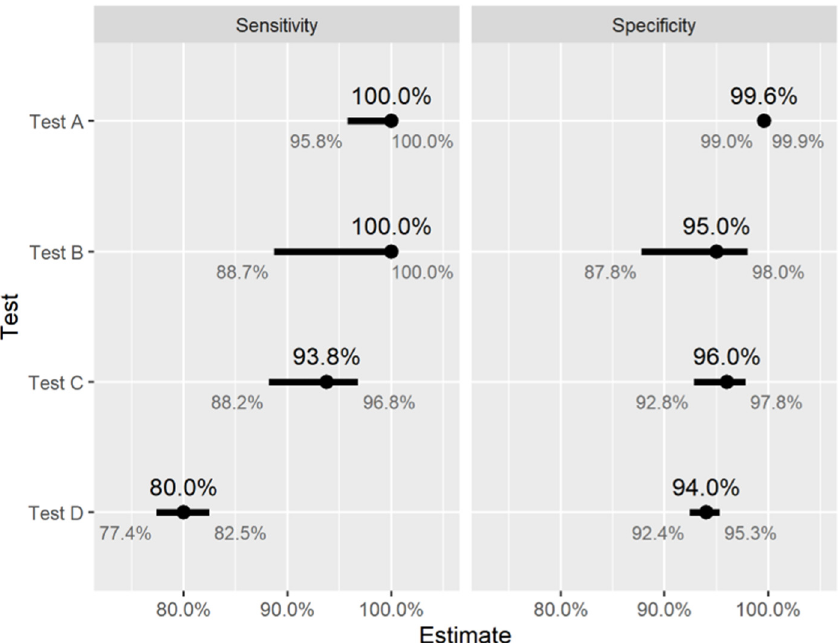
Figure 6. Estimated sensitivity and specificity of four different antibody tests. Tests A, B, and C are based on data presented on the US Food and Drug Administration website (for three different commercially available tests), Test D is for illustrative purposes. Estimated sensitivity and specificity for Test A are both high, with a high degree of certainty (i.e., narrow interval estimates). For Tests B and C, estimated sensitivity and specificity are more uncertain, while for Test D these values are definitely lower.